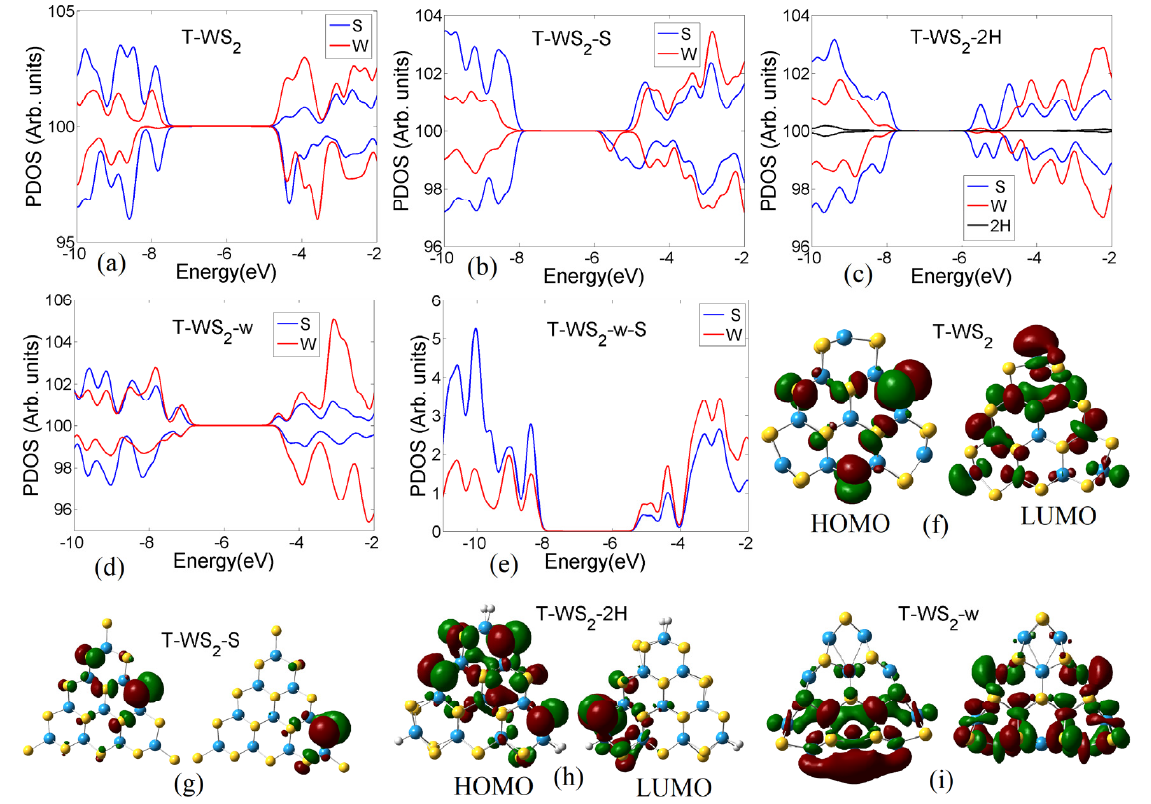
Figure 3. ( a – e ) Electronic partial density of states of T ‐ WS 2 with and without edge passivation. ( f – i ) The corresponding HOMO/LUMO distributions for spin ‐ up molecular orbitals. The red and green colors in ( f – i ) represent the positive and negative phase distribution in the molecular orbital wave function, respectively.